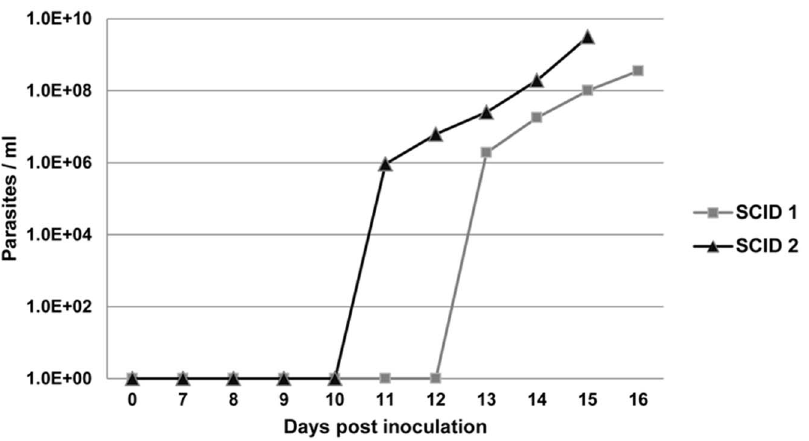
Figure 4. SCID foal infection with cryopreserved sporozoites. Course of parasitemia for SCID foals infected with sporozoites by intravenous inoculation. SCID1=4 6 10 6 ; SCID2=6 6 10 6 sporozoites.